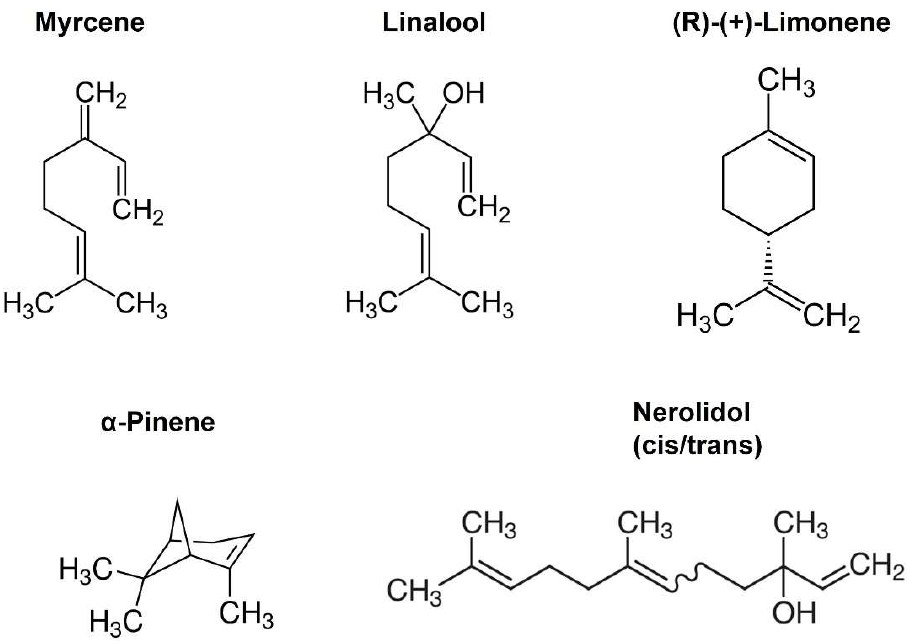
Figure 1. Structures of selected terpenoids.